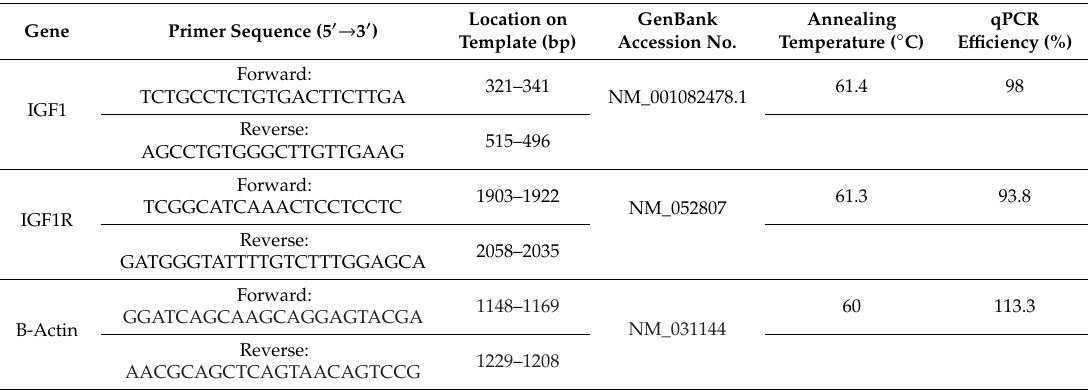
Table 1. Primer sequences for reference genes used for quantitative real-time reverse transcription PCR in rat tissues.